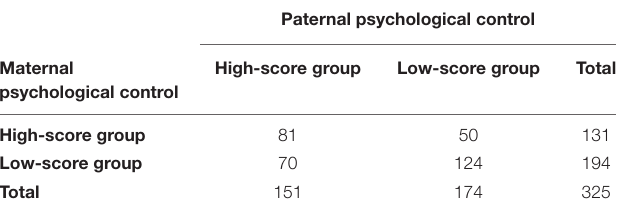
TABLE 2 | Classification of maternal and paternal psychological